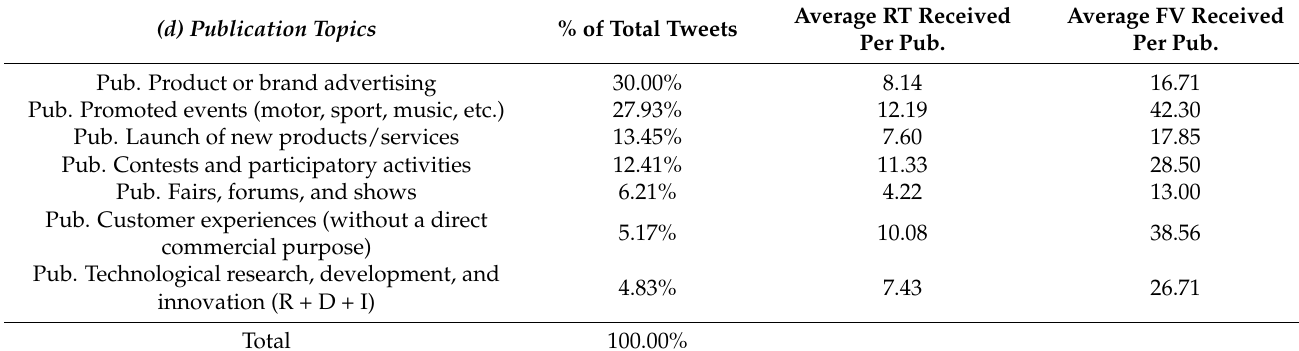
Table 4. Descriptive analysis of variables on category (d) Publication